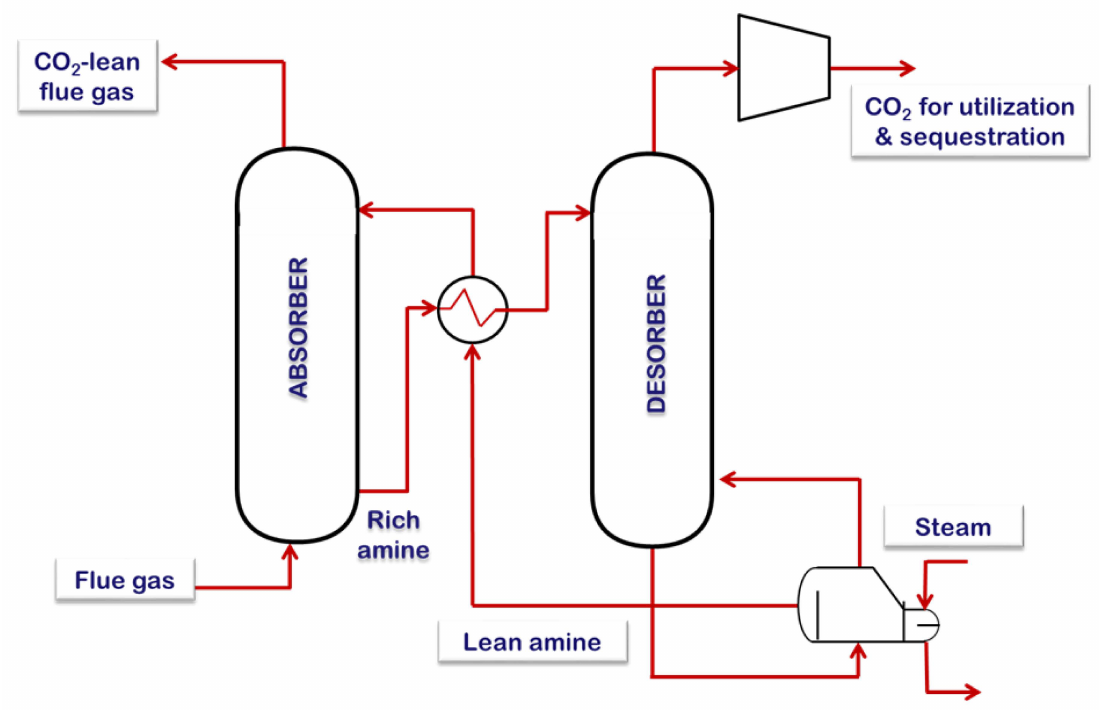
Figure 5. Amine‑based scrubbing process [93], reproduced with permission No.